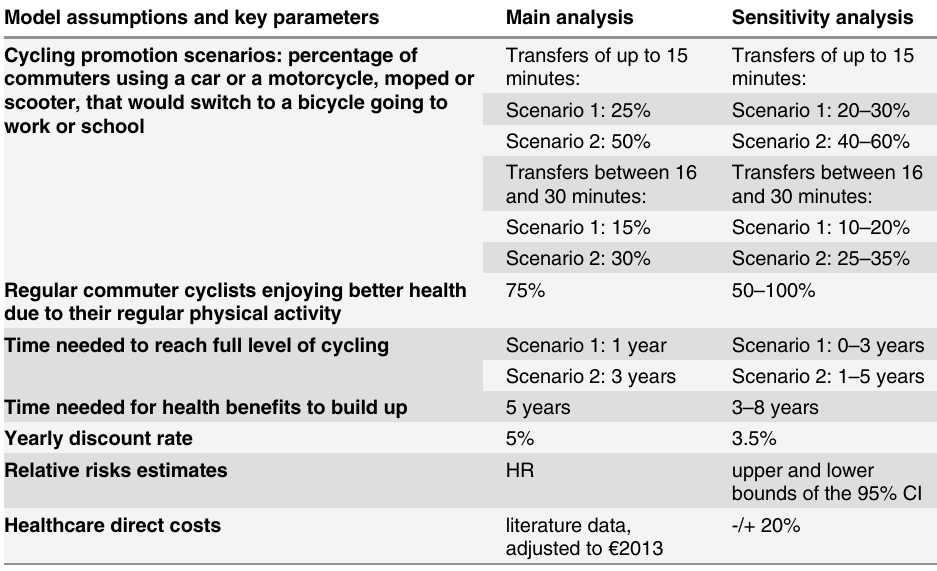
Table 7. Model assumptions, key parameters and sensitivity analysis. Model assumptions and key